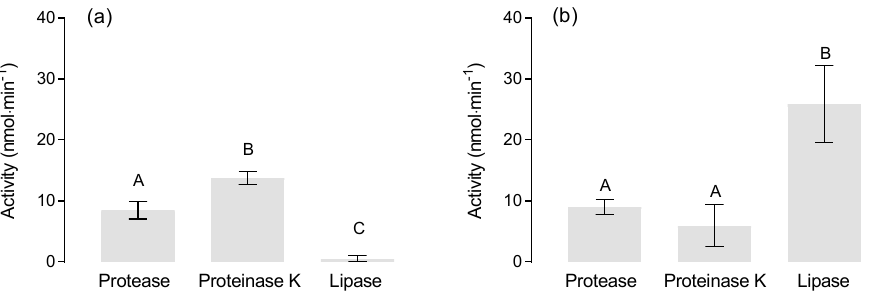
Figure 6. Enzymatic degradation of ( a ) PLA and ( b ) poly(butylene succinate) (PBS) at 22 °C and pH 8.2 (mean ± SD, n = 3). Different letters indicate statistically significant differences (Tukey multiple comparison test).